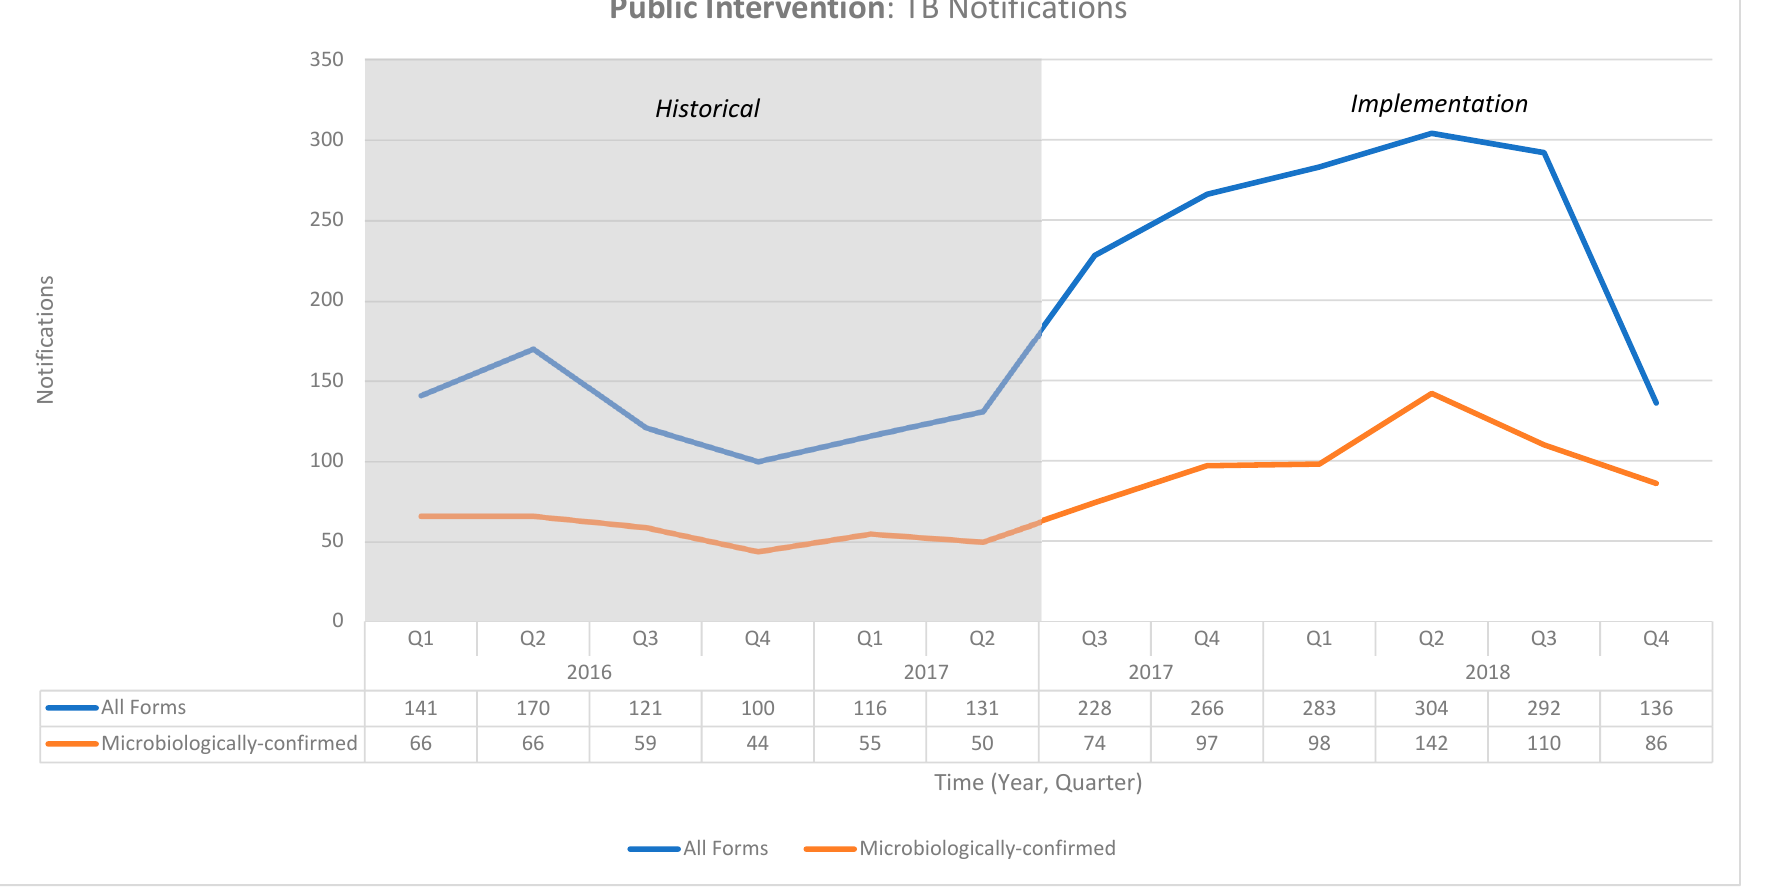
Figure 1. Graph of the notifications in the National TB Elimination Program in the public project intervention area between January 2016 and December 2018.